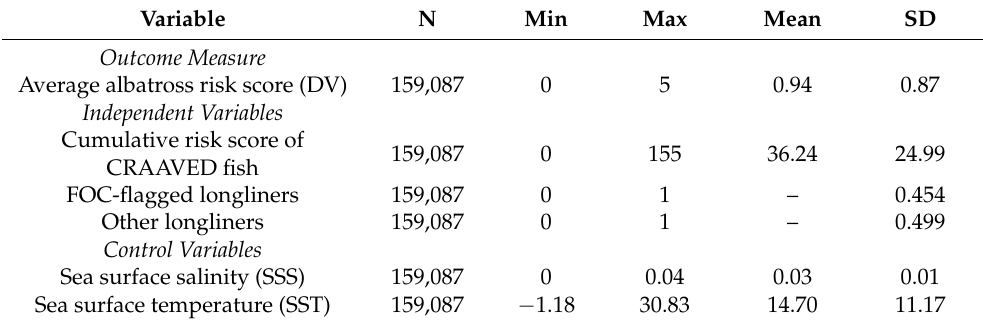
Table 1. Descriptive statistics of study variables. Basic descriptive statistics of the outcome variable (average albatross risk score, calculated as the cumulative risk score of all the albatrosses within a grid cell and based on their IUCN Red List status divided by the number of albatrosses within the given grid cell); three independent variables (cumulative risk score of CRAAVED fish, measured using the risk scores created by Petrossian and Clarke [37]; FOC-flagged longline vessel presence (yes = 1); and other longline vessel presence (yes = 1)); and two control variables (sea surface salinity and temperature).